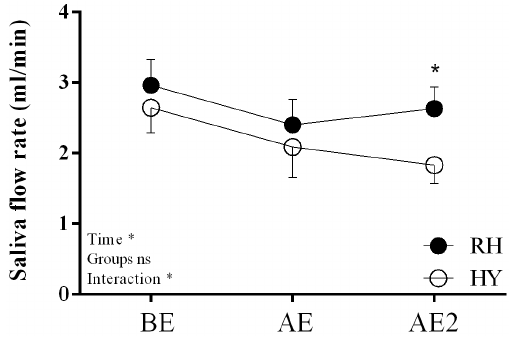
Figure 5. Salivary responses in HY and RH trials; HY = hypohydration condition; RH = rehydration condition; BE = pre-exercise; AE = after exercise; AE2 = after hydration trials. Mean ± SEM; * indicates p <